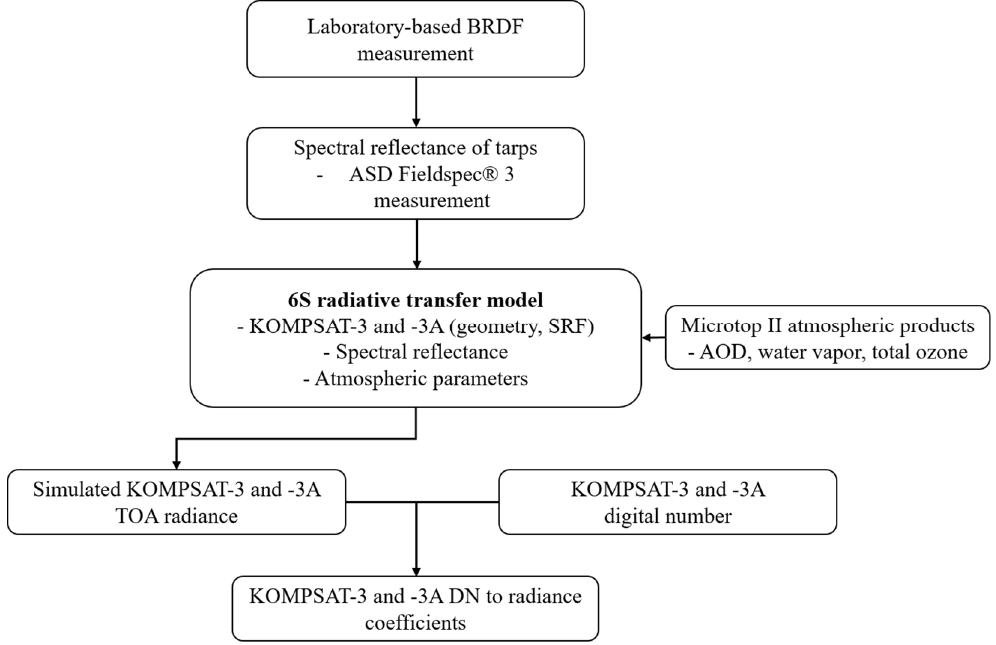
Figure 2. Flowchart showing the vicarious radiometric calibration of KOMPSAT-3 and -3A using the 6S radiative transfer model and related input parameters.